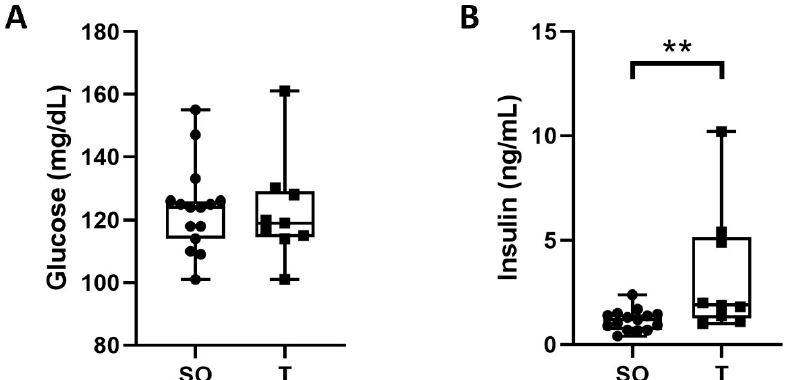
Figure 8. Elevated fasting serum insulin in adult PNA rats. Tail vein blood samples were taken from control ( n = 15) and PNA ( n = 9) rats at 16 weeks of age following an overnight fast. ( A ) A drop of blood was used to determine blood glucose using a standard glucometer. ( B ) Serum insulin concentrations were measured by ELISA. While fasting blood glucose levels were comparable, fasting serum insulin was significantly higher in the PNA rats. Data were analyzed by Mann–Whitney U tests and are shown as quartiles with the median. ** p < 0.005.